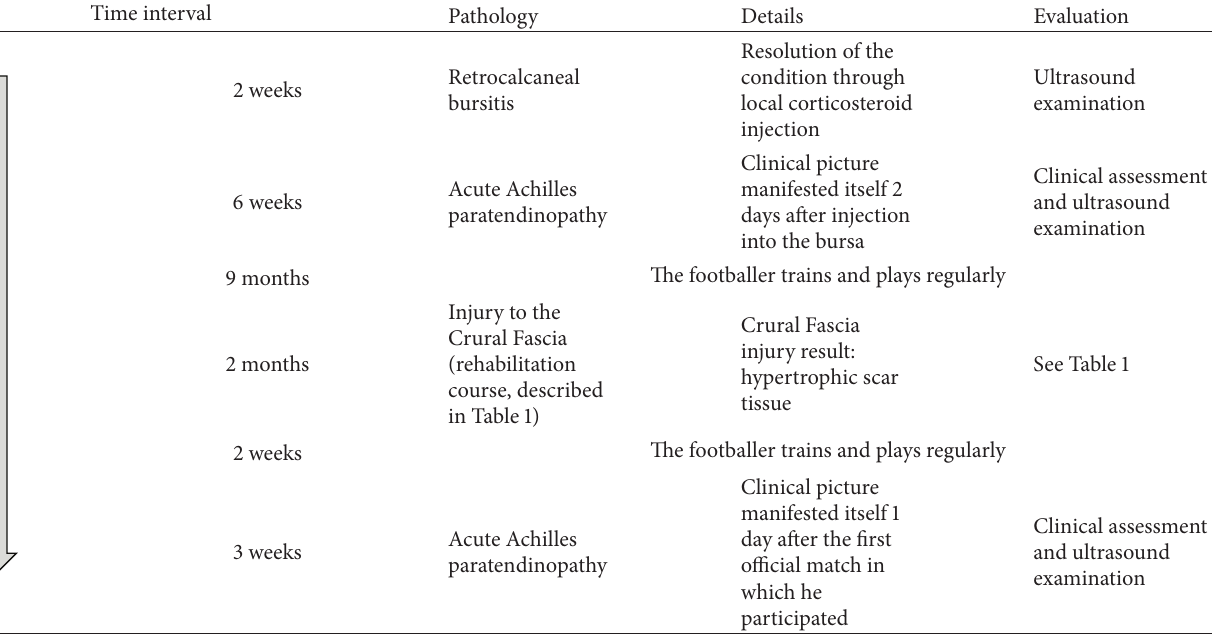
Table 2: Timeline. Summary of the relevant player’s clinical